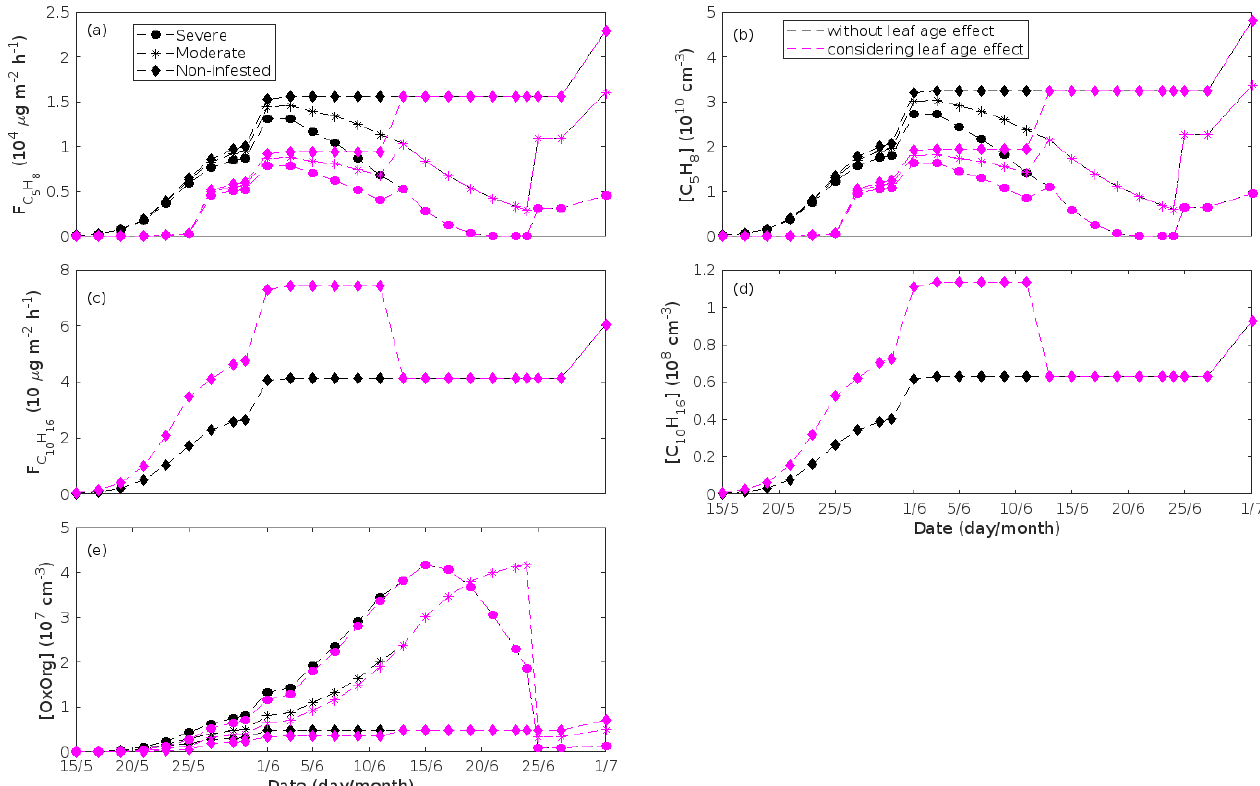
Figure B1. An oak stand infested with European gypsy moth larvae in comparison to a non-infested oak stand simulated with and without considering the impact of leaf age on the rates of emissions. Canopy emissions of (a) isoprene and (c) monoterpenes and atmospheric concentrations of (b) isoprene, (d) monoterpenes, and (e) OxOrg. “Moderately” and “severely” refer to 30% and 80%, respectively, of the leaf area having been consumed by the end of the feeding period. Black markers are for simulations where the effect of leaf age was not considered, while magenta markers are for simulations where the effect of leaf age was considered. Simulation results for severe are always indicated by circles, by asterisks for moderate, and by diamonds for non-infested (independent of whether the effect of leaf age was considered or